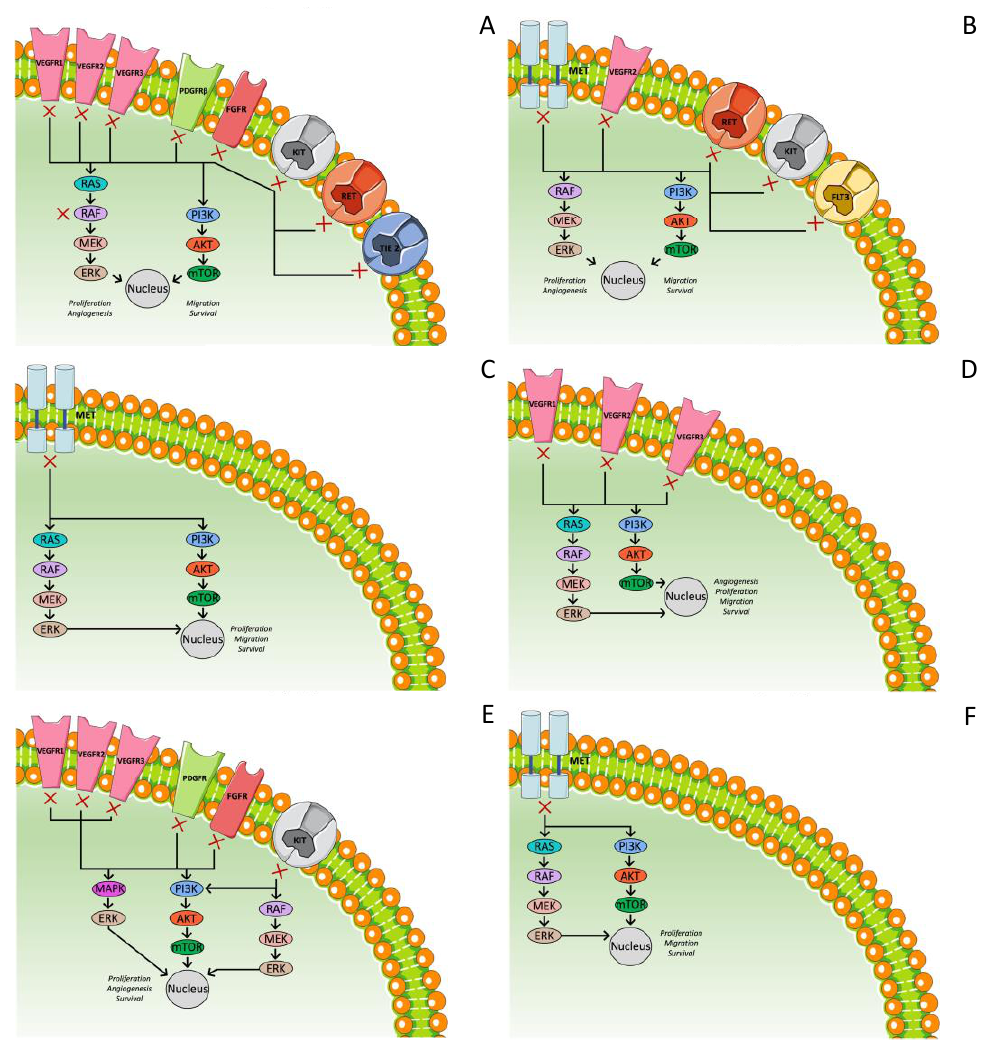
Figure 3. Mechanism of action of multi-targeted tyrosine kinase inhibitor for second-line treatment of HCC. ( A ) Regorafenib; ( B ) cabozantinib; ( C ) tivantinib; ( D ) axitinib; ( E ) anlotinib; ( F ) tepotinib.